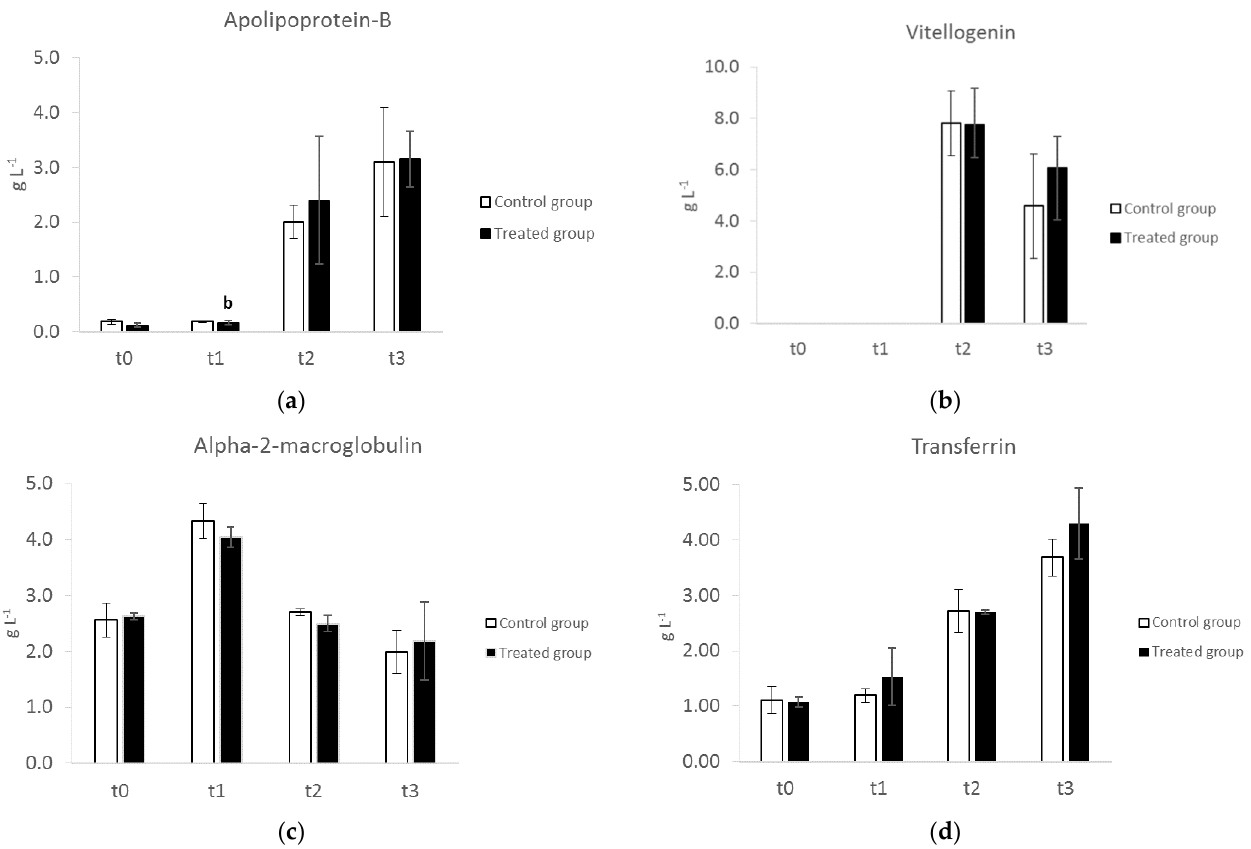
Figure 3. Variation in selected serum proteins in control and supplemented hens at different time points: t0, start of the trial; t1 (5th week), before the start of laying; t2 (12th week), end of the supplementation; and t3 (19th week), end of the trial. The concentrations were obtained after densitometric analysis of protein bands and are expressed as g L − 1 (n = 4). Bars sharing the same symbol (control hens) or the same letter (treated hens) are significantly different ( p < 0.05).